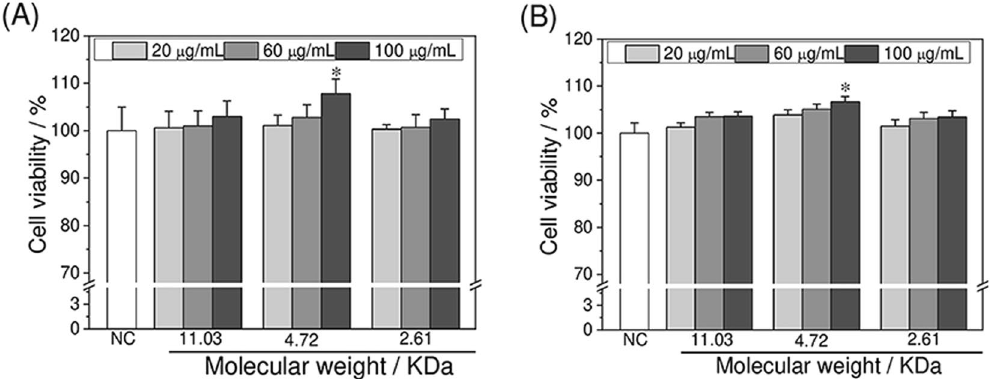
Figure 1. Cytotoxicity of different Mw APS on HK-2 cells detected by CCK-8 ( A ) and MTT ( B ) methods, respectively. HK-2 cells were incubated with polysaccharide for 24 h. Compared with normal control (NC) group, * p < 0.05.